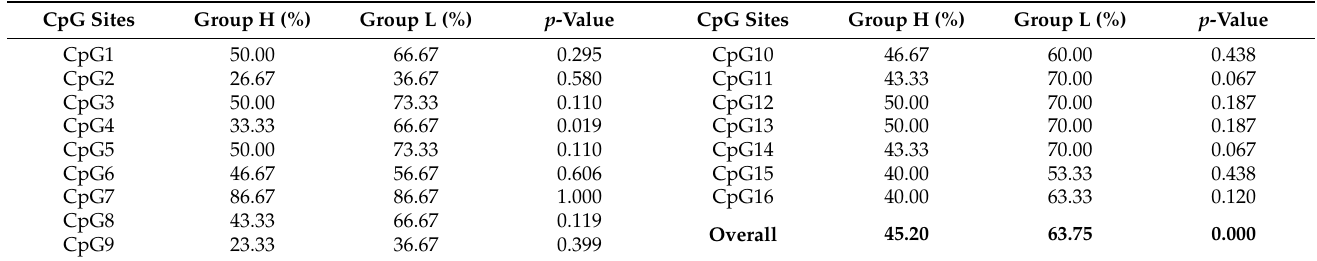
Figure 7. The detection of methylation in high and low yield groups at CpG I–III sites. ( A – C ) are the methylation detection patterns of high and low yield groups at CpG I, II, and III sites, respectively. ( D – F ) are the methylation level of high and low yield groups at CpG I, II, III sites, respectively. Table 3. Methylation levels of CpG I sites in the high and low yield